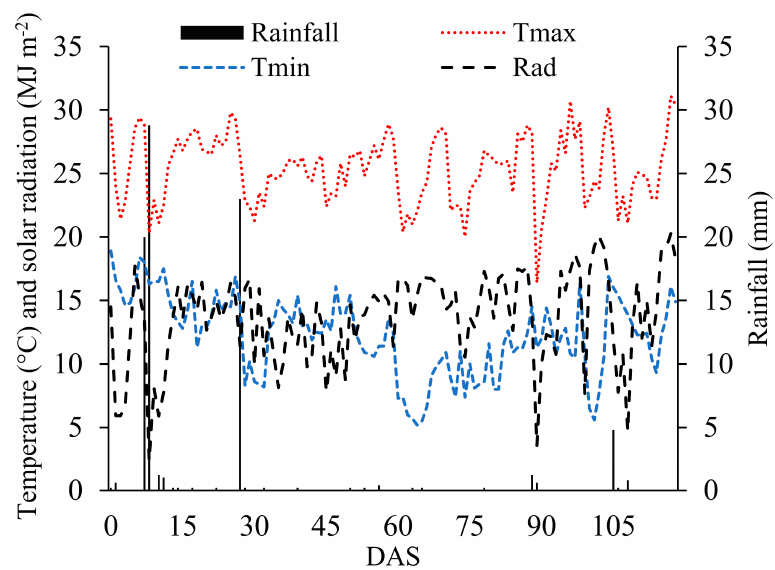
Figure 2. Daily values of solar radiation (Rad), maximum air temperature (Tmax), minimum air temperature (Tmin), and rainfall (Rainfall) during the experiment.